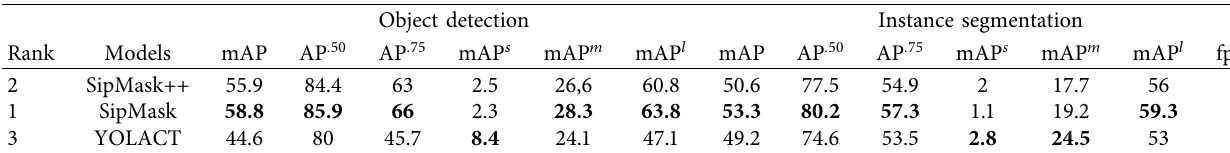
Table 4: A performance comparison ranking of SipMask++, YOLACT-550, SipMask, and YOLACT instance segmentation performance against the workshop repair dataset.